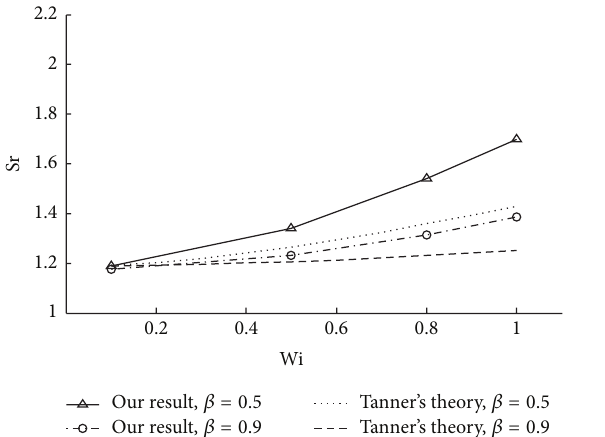
Figure 8: Swelling ratio with the increase of Wi for 𝛽 = 0.5 and 𝛽 = 0.9 .